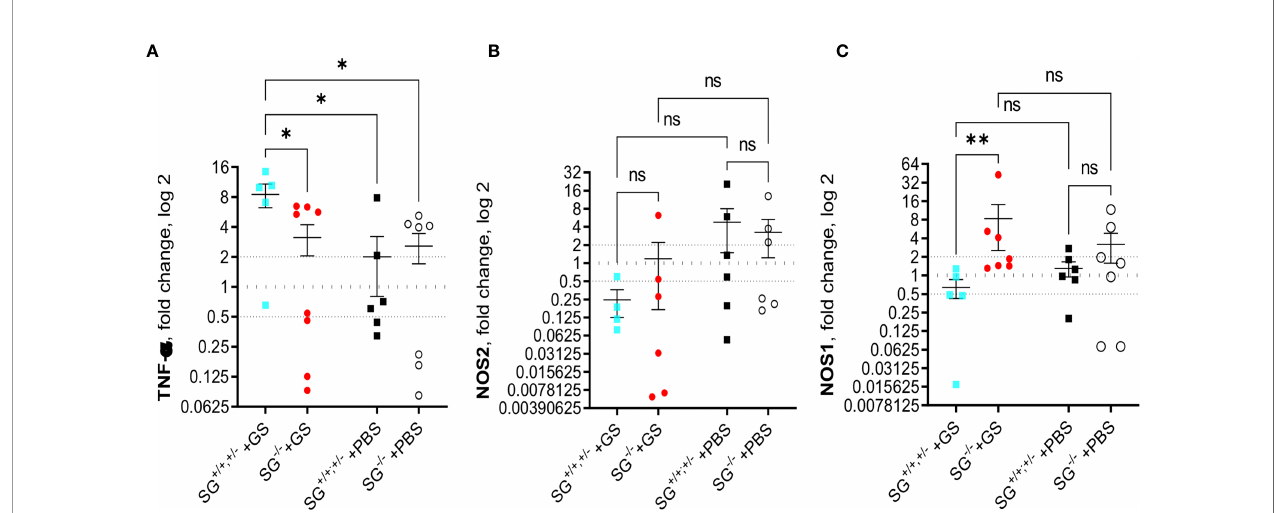
FIGURE 4 | Intestinal expression levels of TNF- a and nitric oxide synthases (NOS) in SG +/+ and SG -/- littermate mice infected with Giardia intestinalis . Relative intestinal expression levels of (A) TNF- a , (B) inducible NOS2, and (C) ubiquitously expressed NOSI, determined by qPCR. Fold changes were calculated after normalization to GAPDH. Dotted lines at 0.5, 1, and 2 indicates down-regulation, no fold change, and up-regulation, respectively. ns= non-signi fi cant, P values * <0.05, ** <0.01.